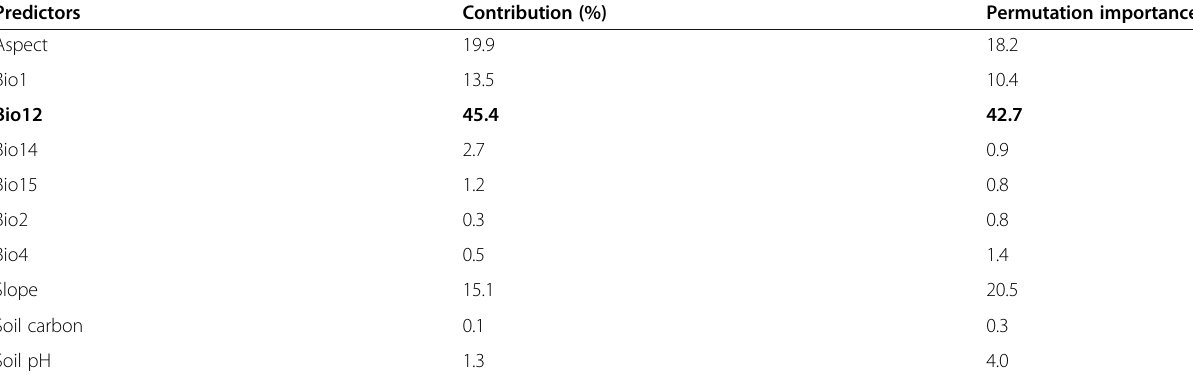
Table 3 Relative contribution and permutation importance of the environmental predictors influencing the probability of distribution of Q. aegilops in the KRI